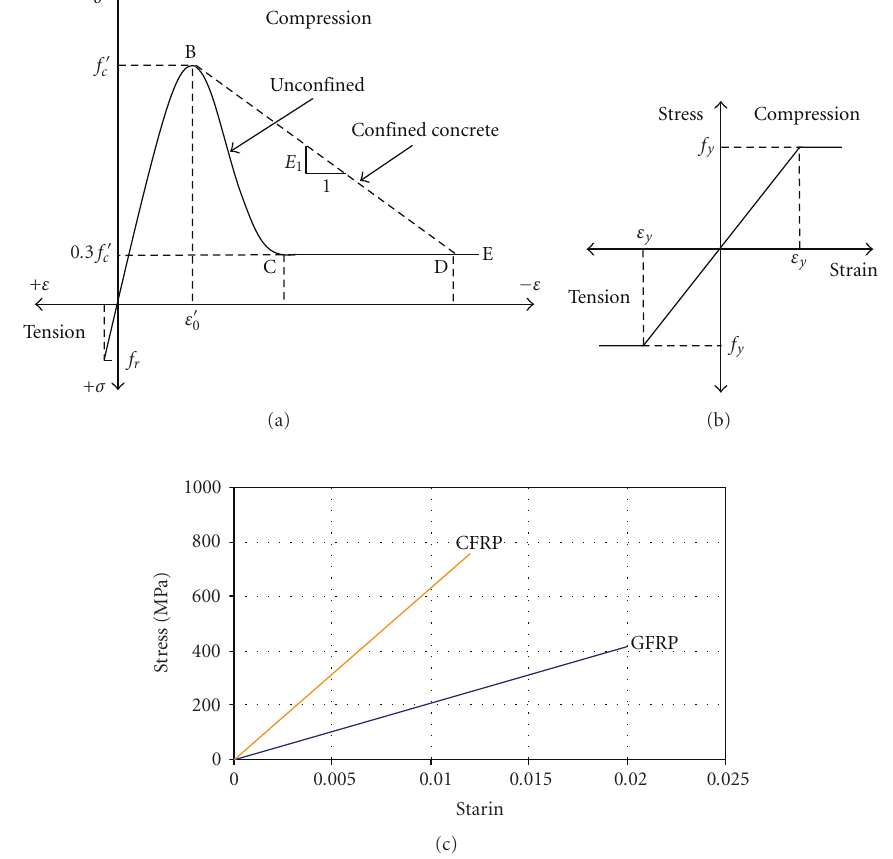
Figure 2: Uniaxial stress-strain curve: (a) Concrete; (b) steel reinforcement; (c) fRP composites in the fiber